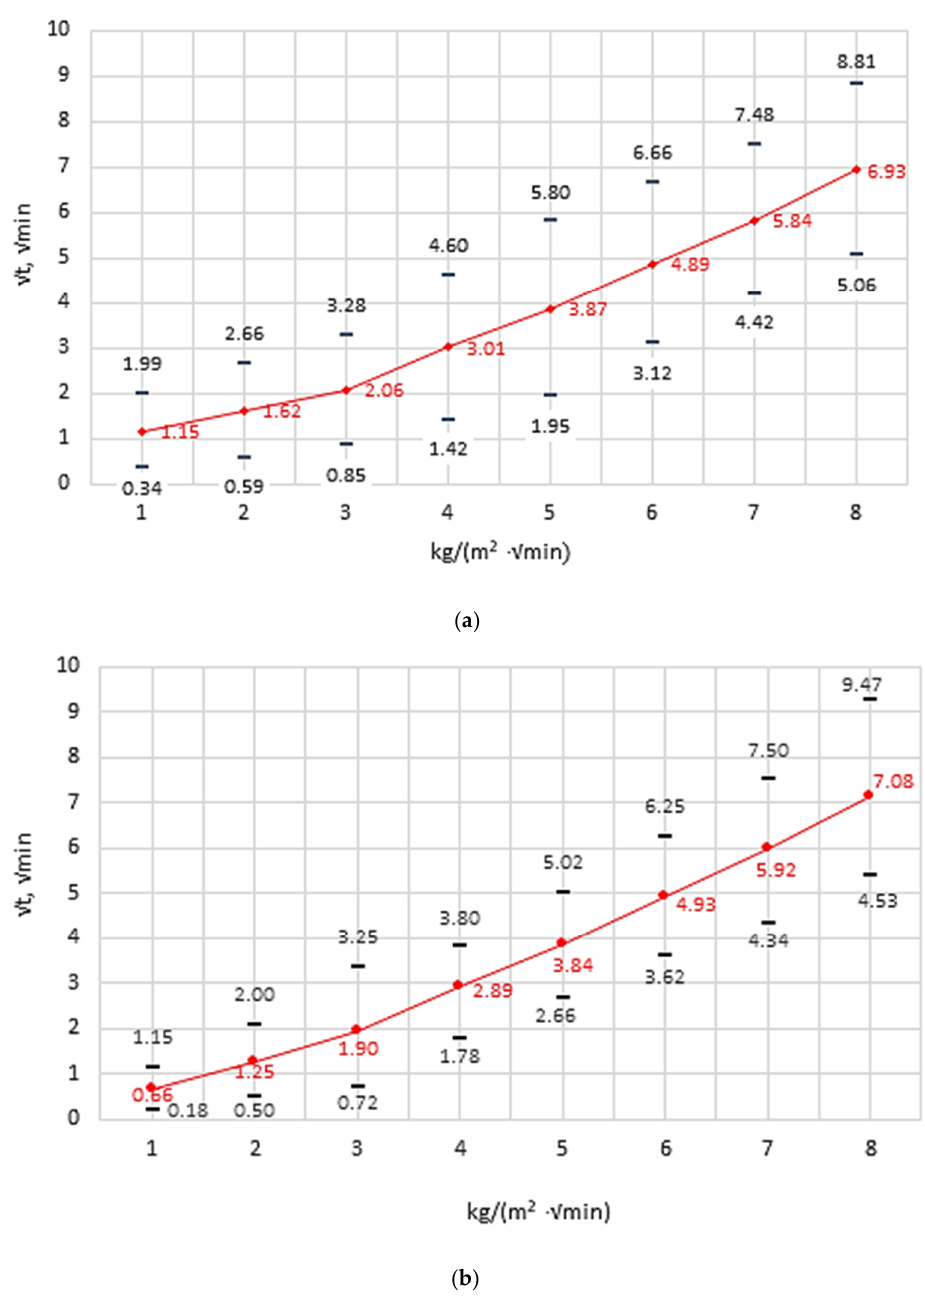
Figure 6. Capillary absorption of tested samples: ( a ) group A samples, ( b ) group B samples.